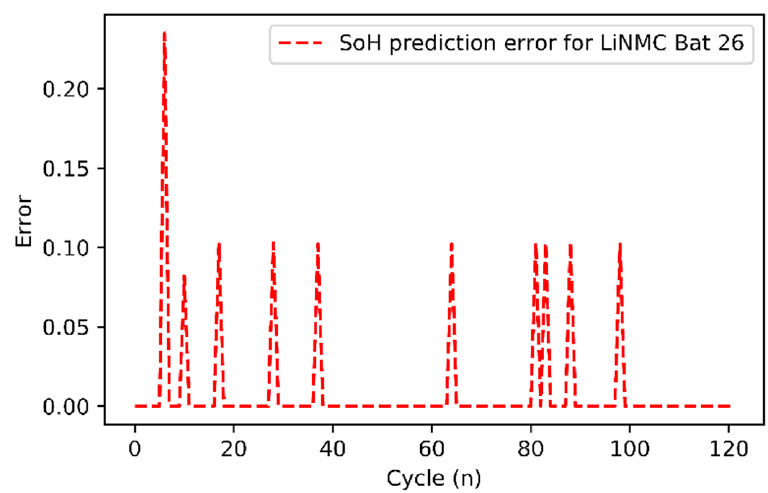
Figure 10. The error in predicting the SOH for battery 26.